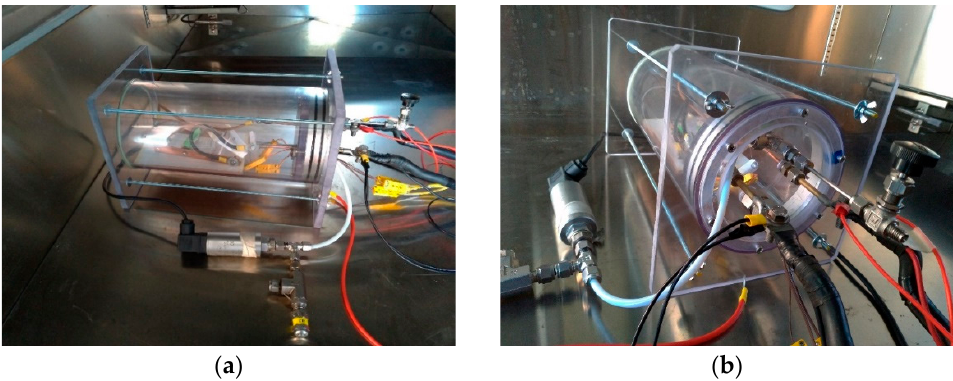
Figure 2. Pictures of the instrumented box: ( a ) front view, ( b ) side view. Table 1. Main parameters of the tested cells.